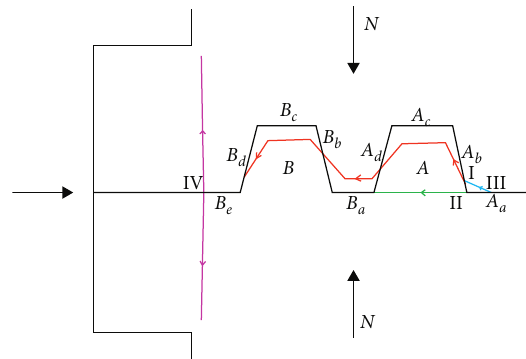
Figure 7: Crack development of double mortise-tenon joint with auxiliary pretightening device in tension side.